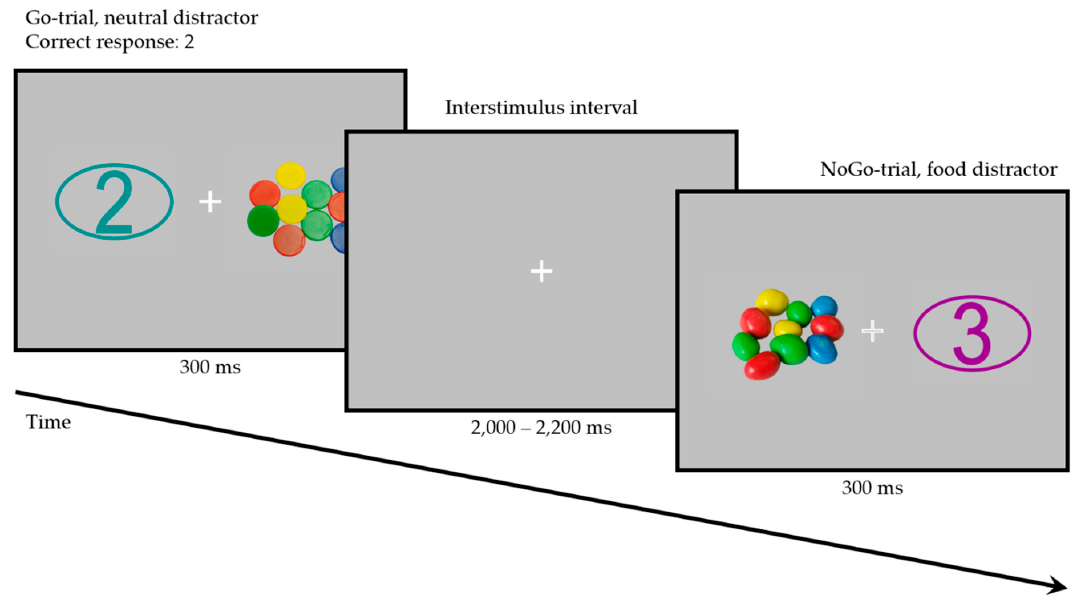
Figure 1. Example of a Go trial with a neutral distractor and Target Number 2 (left; target color: turquoise) and of a NoGo trial with a high-calorie food distractor (right). Note: The distractor stimuli depicted here are for illustrative purposes only and were not used in the study.